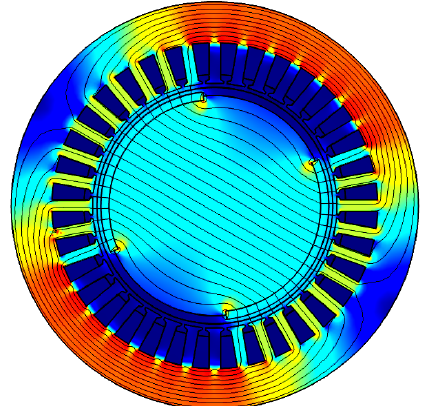
Fig. 5. The mesh distribution of the model. The mesh consist a total of 38508 elements.